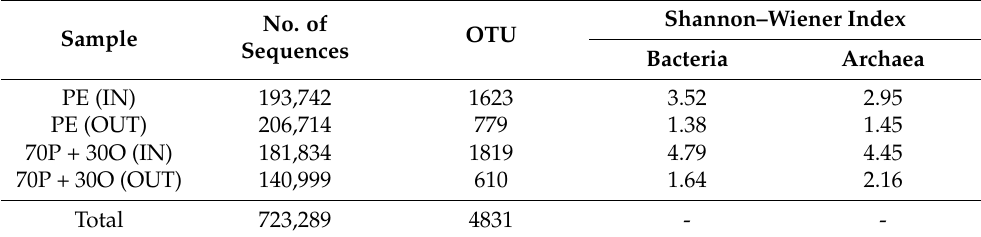
Table 9. Sequencing summary and microbial community (bacteria and archaea) diversity index of